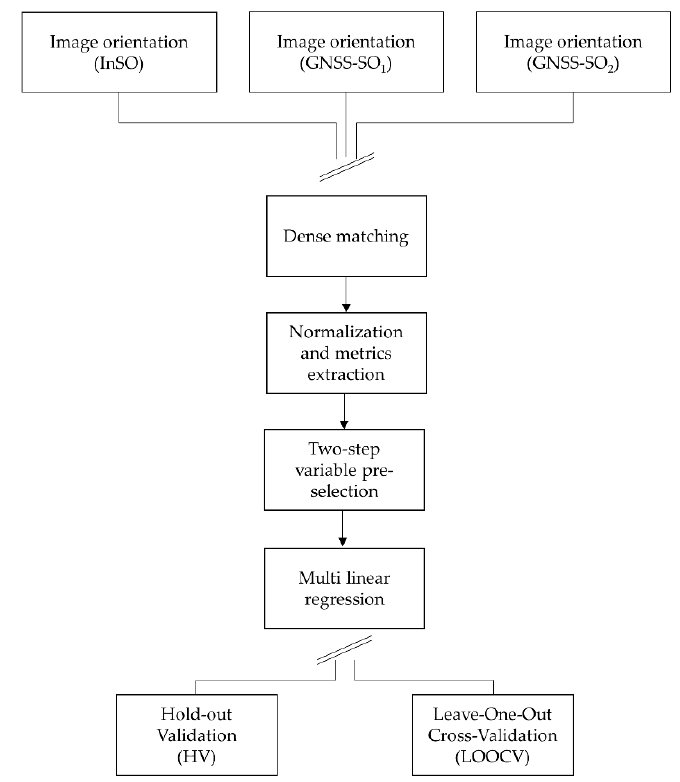
Figure 2. The simplified methodological workflow of the study.